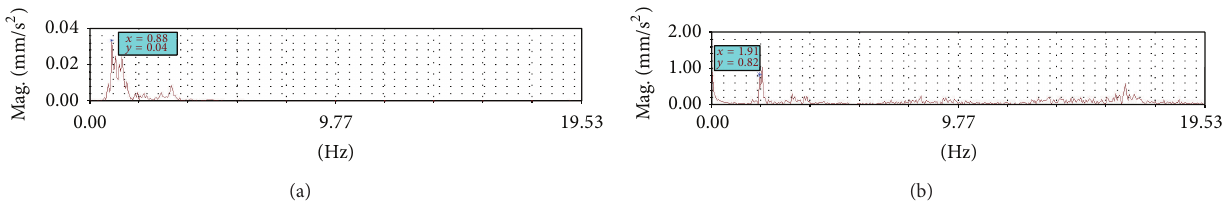
Figure12:PowerspectrumsoftheaccelerationresponsesinthespanofS007-S008:(a)longitudinalbridgedirectionand(b)verticaldirection.